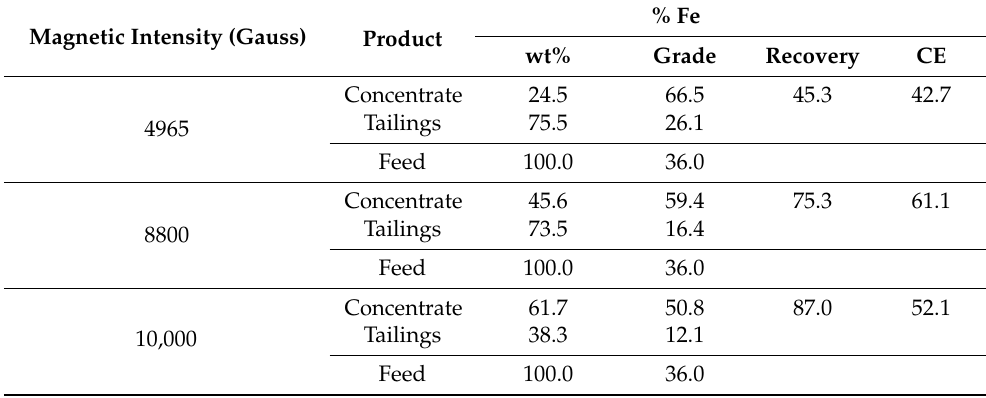
Table 5. Amenability to WHIMS by varying magnetic intensity and other parameters of